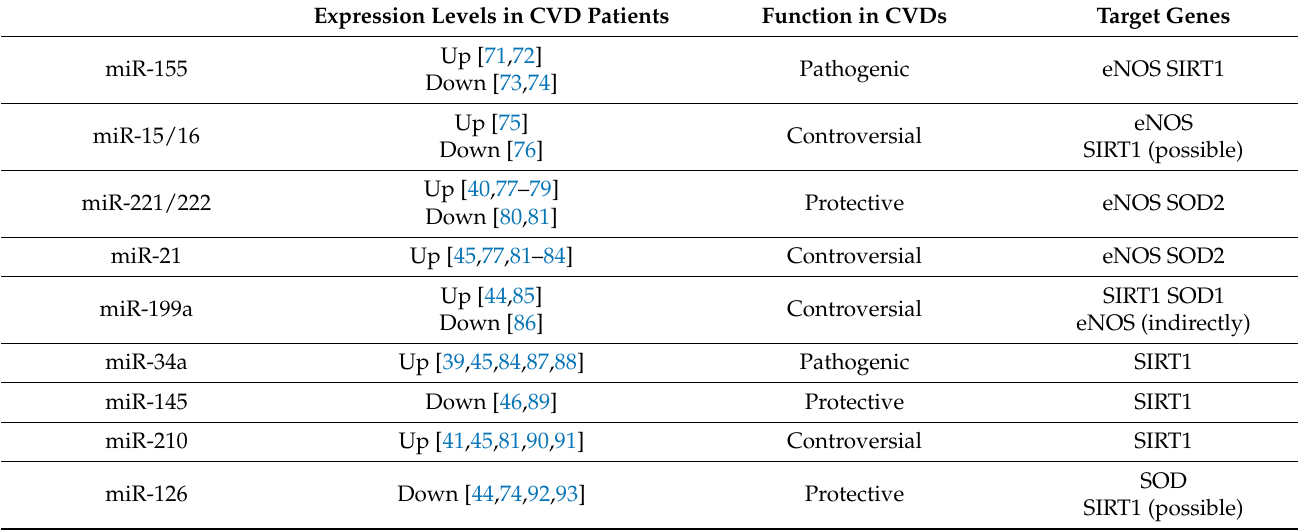
Table 1. miRNA expression in CVD patients, their function in the pathology of CVDs, and their potential target genes involved in ROS level